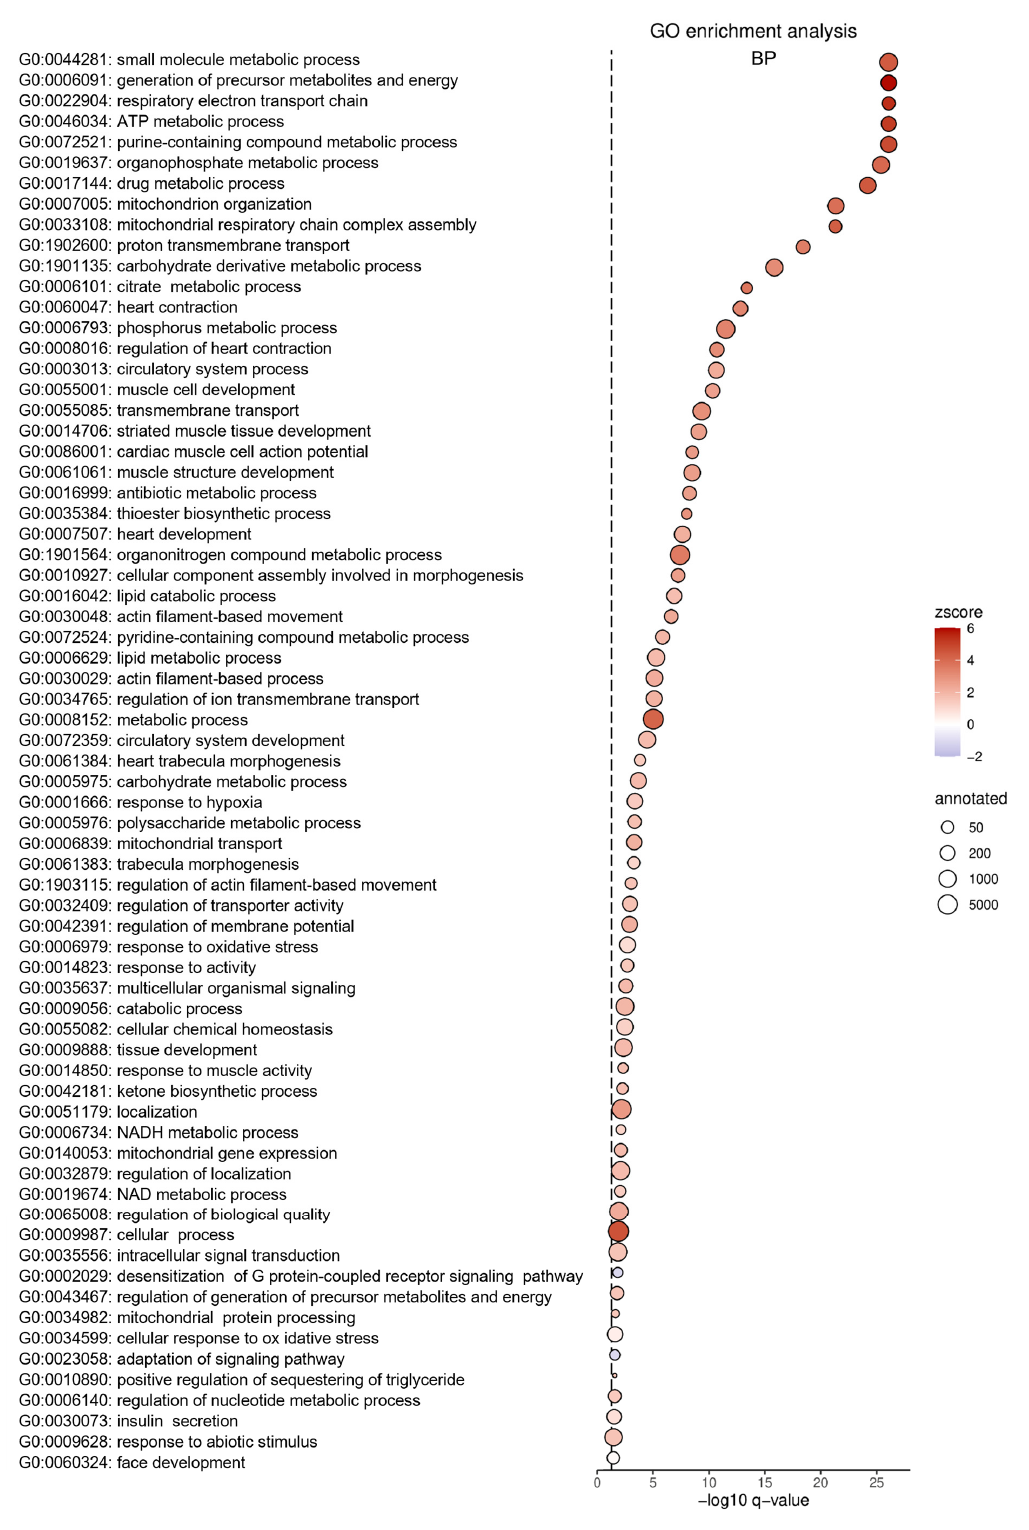
Figure 6. Altered GO terms in Gpr15 gfp/gfp mice after induced myocardial infarction. Significant gene ontology (GO) terms for biological processes (BP) clustered utilizing Revigo. Differentially expressed GO terms for Gpr15 gfp/gfp mice include response to hypoxia , desensitization of GPCRs and intracellular signal transduction . The GO term ID and the description were plotted according to their p -value as dot plot. On the x -axis, the negative decadic logarithm of the p -value of the GO terms